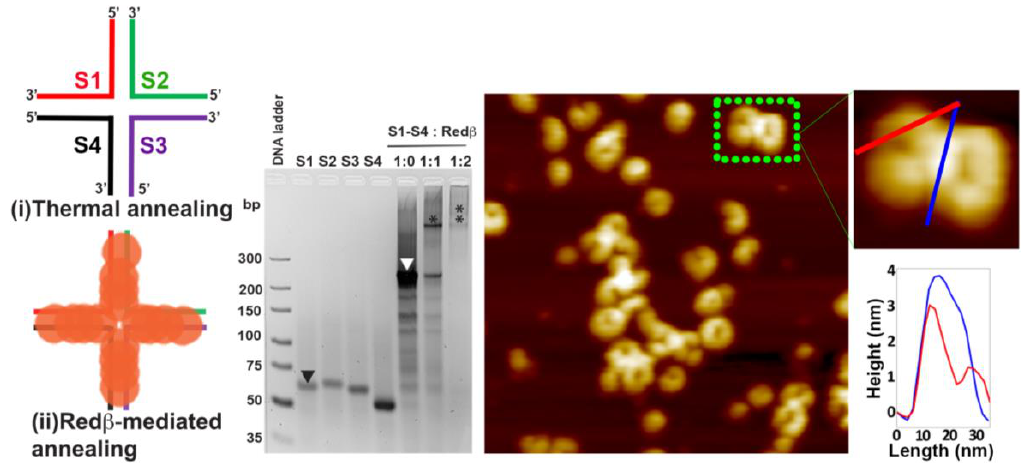
Figure 4. The schematic structures show the 88 mer HJ junction design assembled by thermal ( i ) and Redβ-mediated ( ii ) annealing. The sodium borate agarose gel analysis shows the saturation concentration ratio of Redβ to ssDNA. The downward-facing black and white arrowheads in the gel image indicate the free ssDNA and self-annealed HJ structures without protein, respectively, while the asterisks indicate the protein-annealed HJ structures. The AFM image depicts the resulting Redβ-mediated HJ assemblies. The height profiles were taken along the lines indicated in the zoom. The AFM image has a size of 300 × 300 nm² and a height scale of 4 nm.